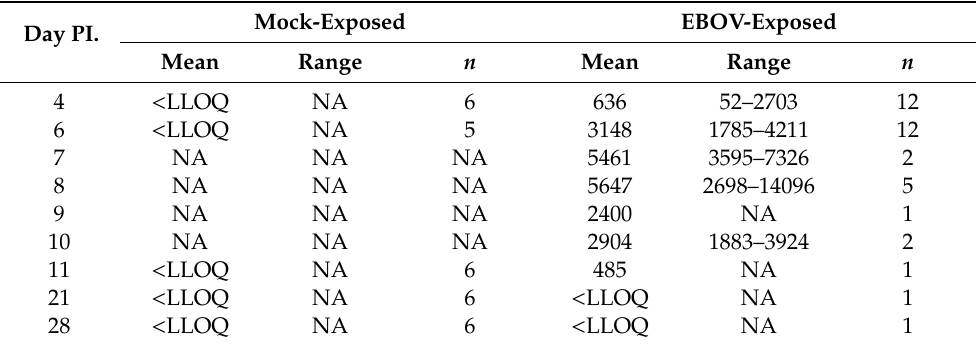
Table 2. Serum soluble glycoprotein concentration (ng /